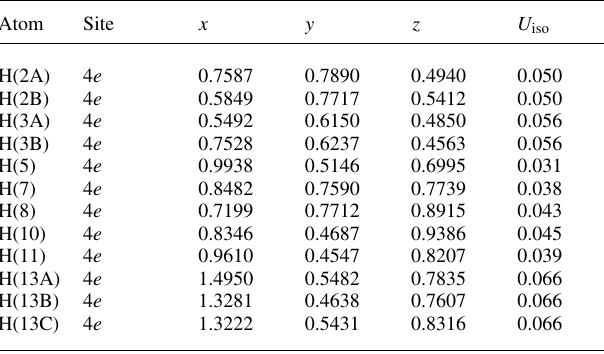
Table 2. Atomic coordinates and displacement parameters (in Å 2 )